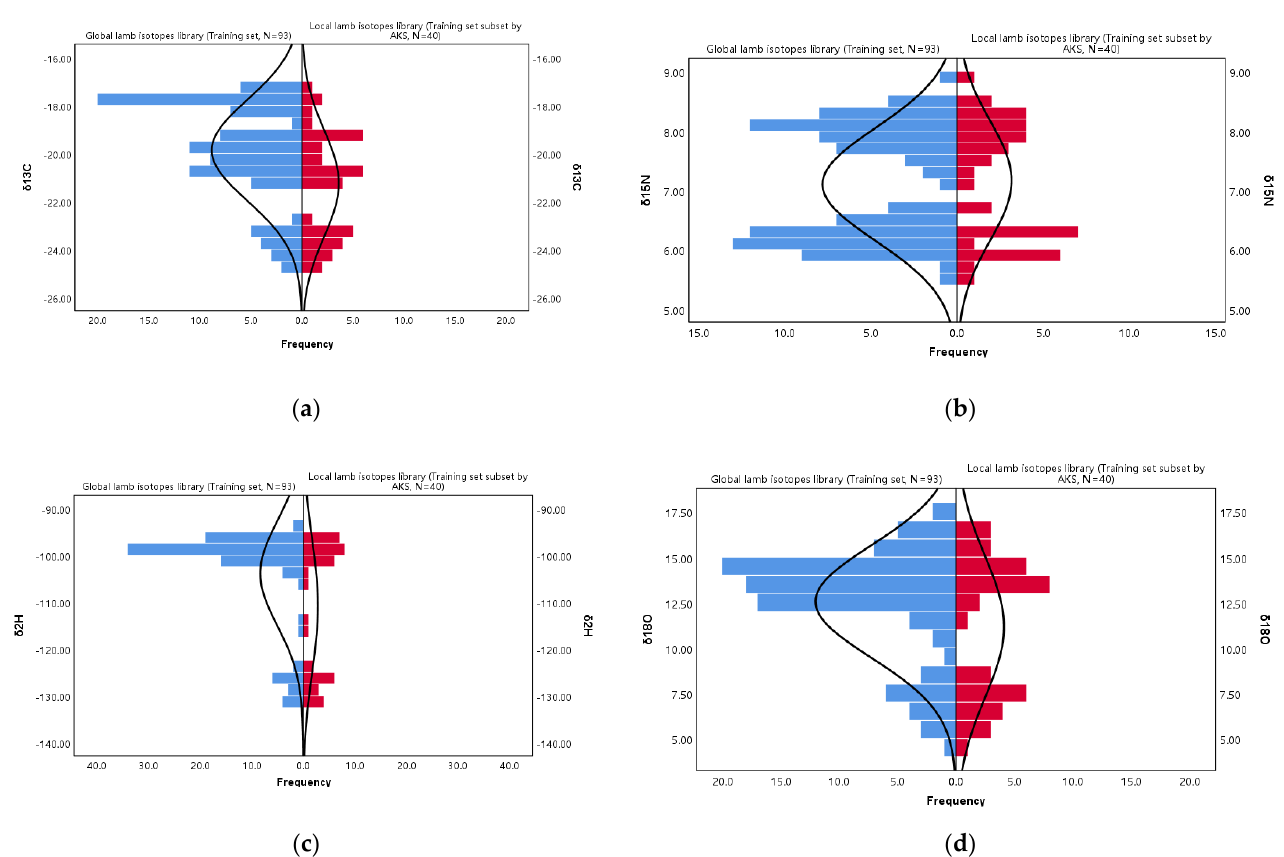
Figure 3. Histograms of the δ 13 C ( a ), δ 15 N ( b ), δ 2 H ( c ), and δ 18 O ( d ) values of the global lamb isotope library and local lamb isotope library.